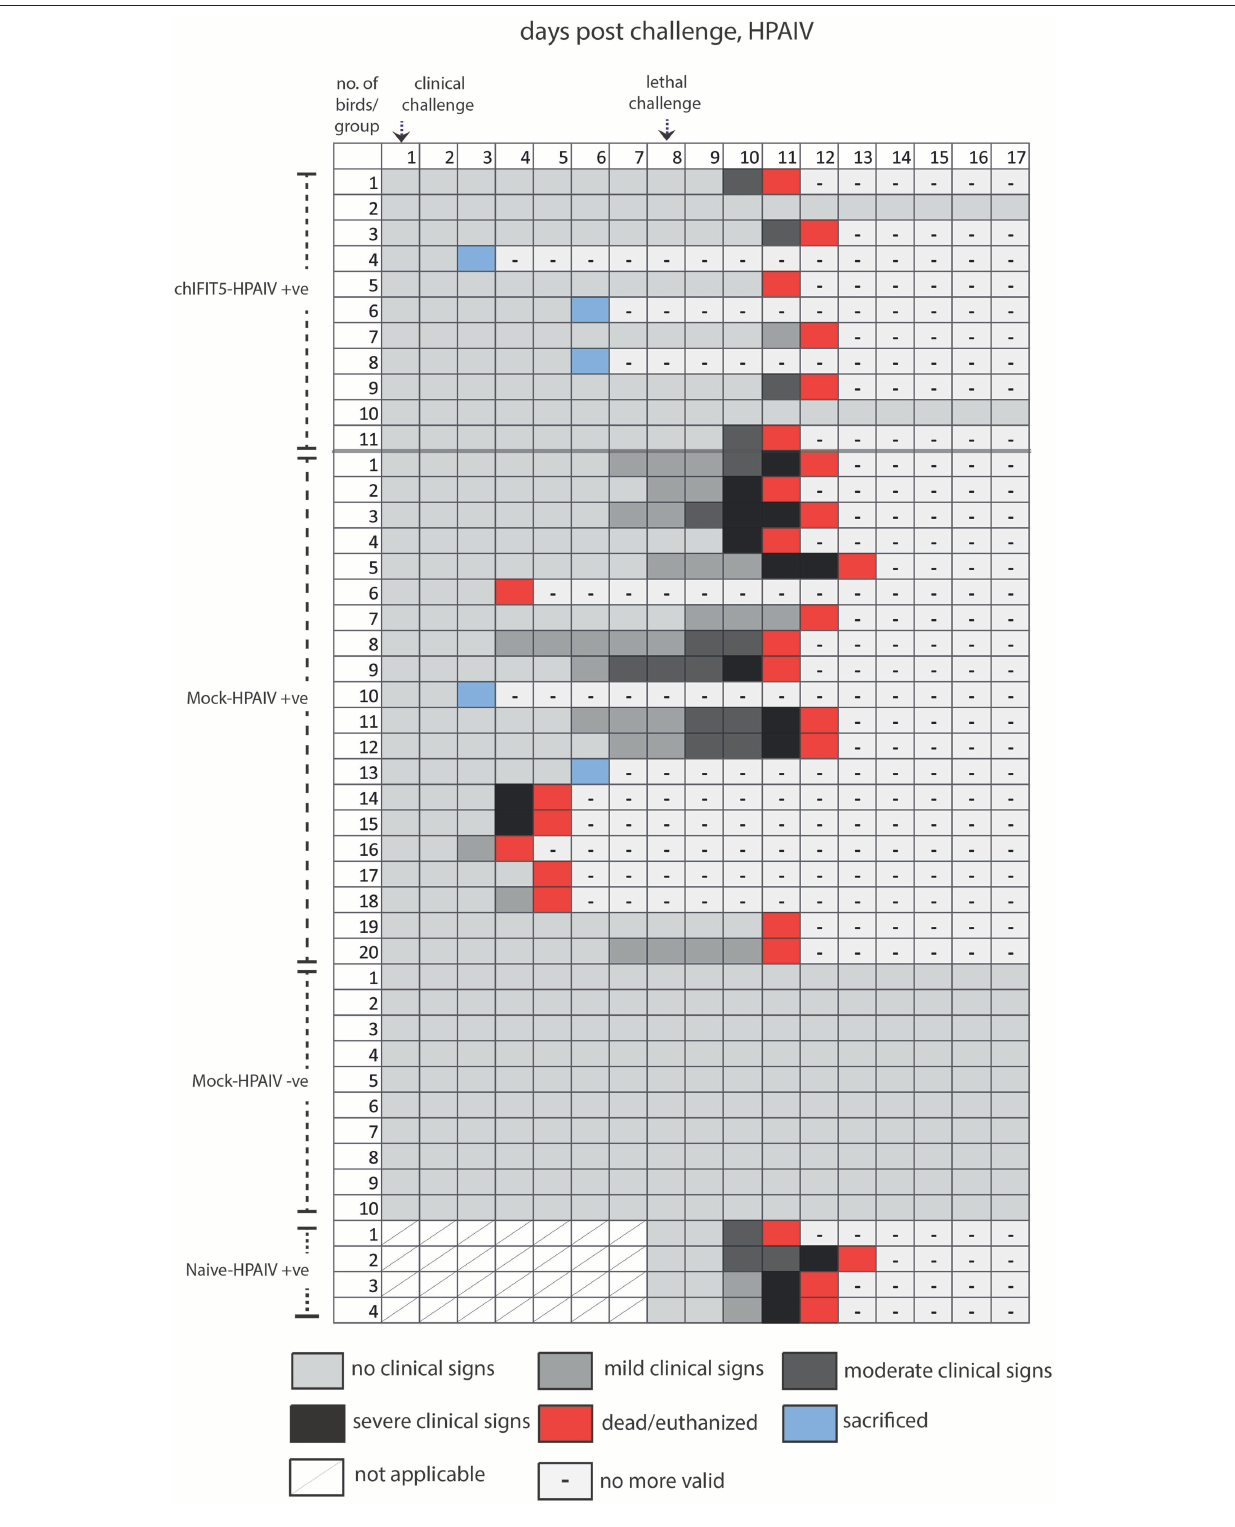
Frontiers in Immunology | www.frontiersin.org